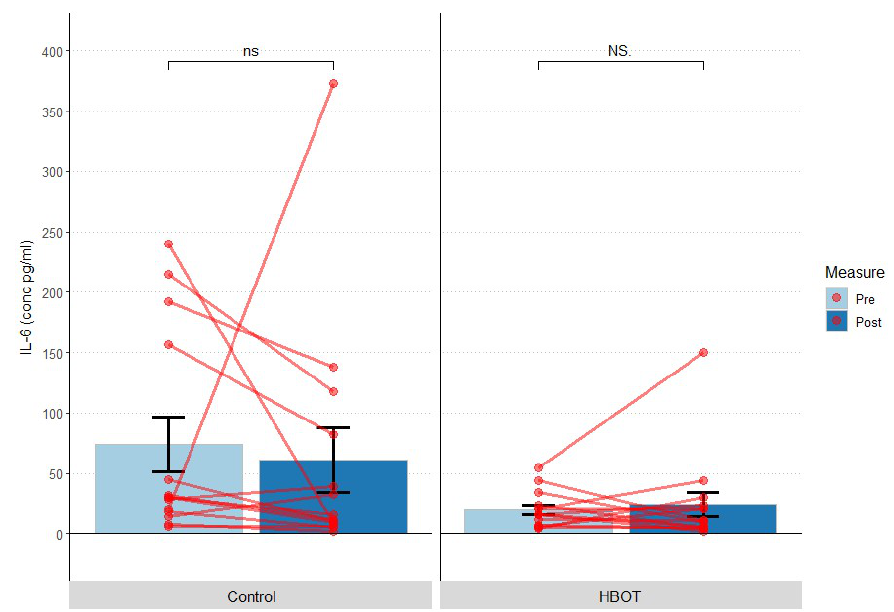
Figure 7. Change in interleukin 6 levels at first measurement (Pre) and 10 days after study onset (Post); bars represent mean, error bars represent standard error, red lines represent individual patient results; ns p > 0.05, NS p > 0.999; HBOT n = 14, Control n = 14.